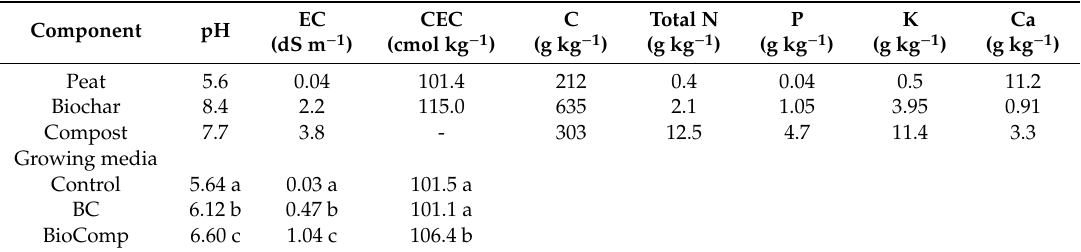
Table1. Chemicalpropertiesofbiochar, compost, andgrowingmediaatthebeginningoftheexperiment.